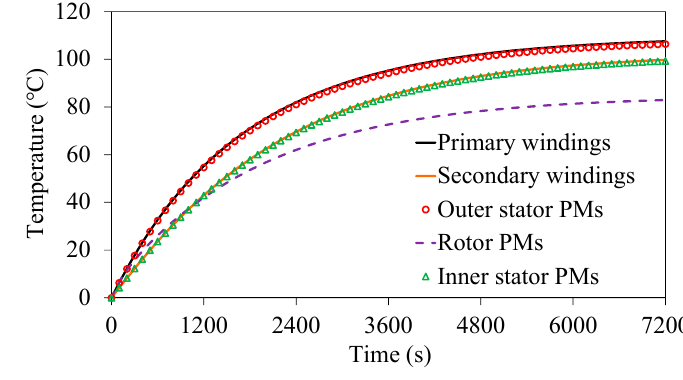
Figure 17. The temperature curves.